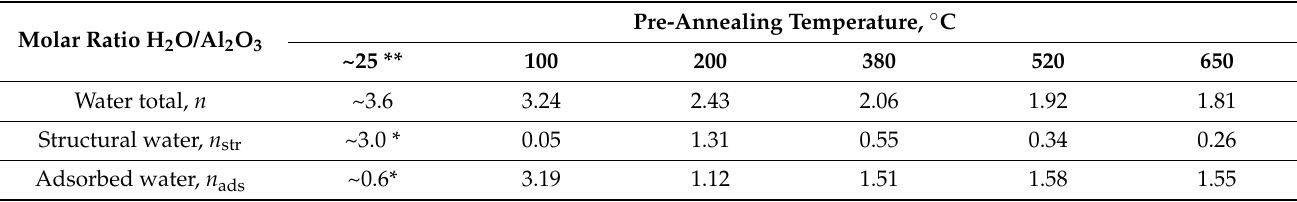
Table 2. Water content in PMOA-M samples: Al 2 O 3 · n H 2 O · x (SiO 2 ), were n = n str + n ads . Molar Ratio H 2 O/Al 2 O